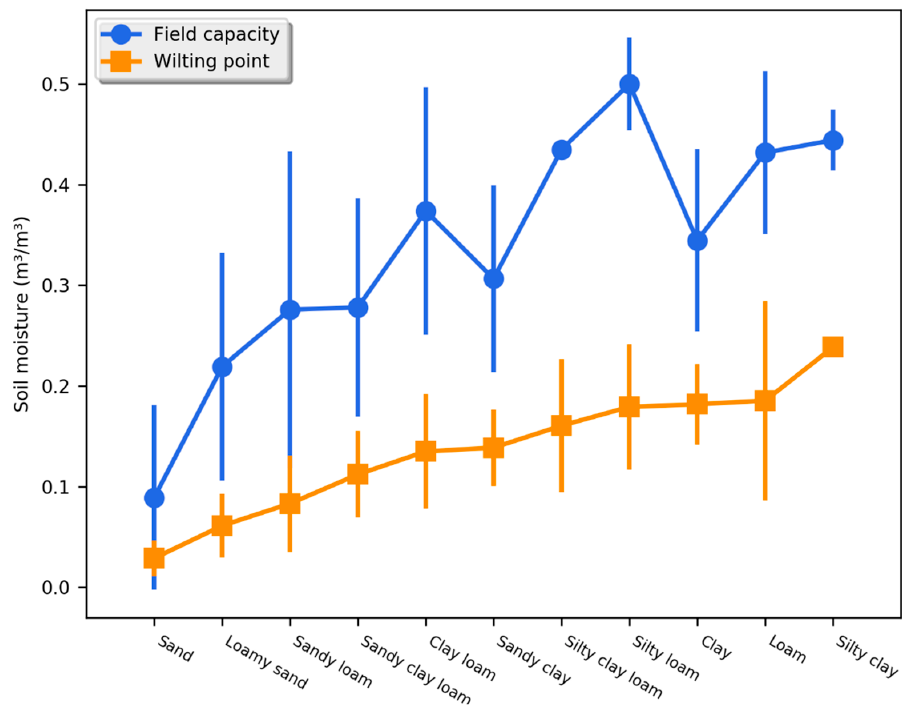
Figure 4. Average wilting point and field capacity for each soil texture over the region. Vertical bars denote the standard deviation.